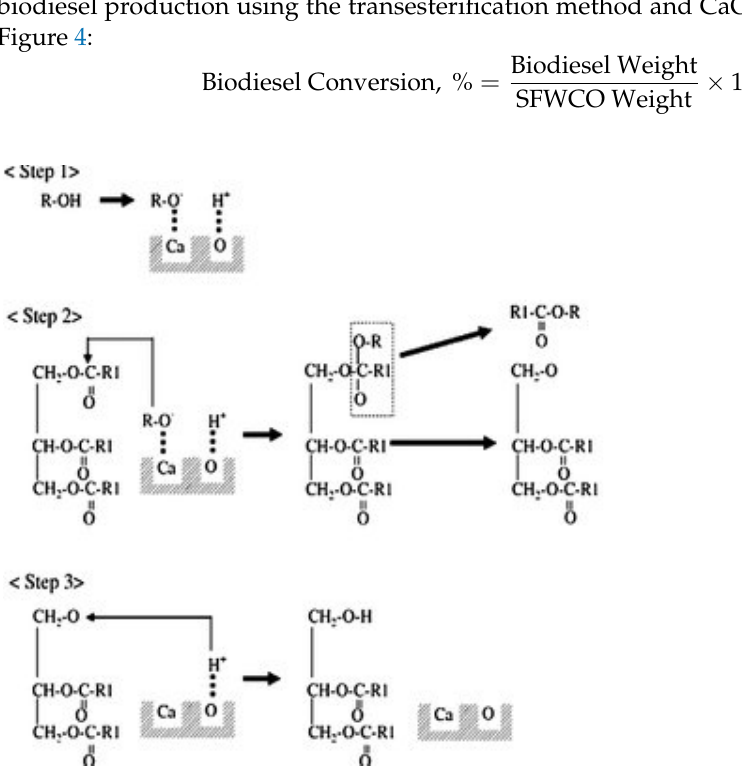
Figure 3 . Experimental setup for biodiesel production .